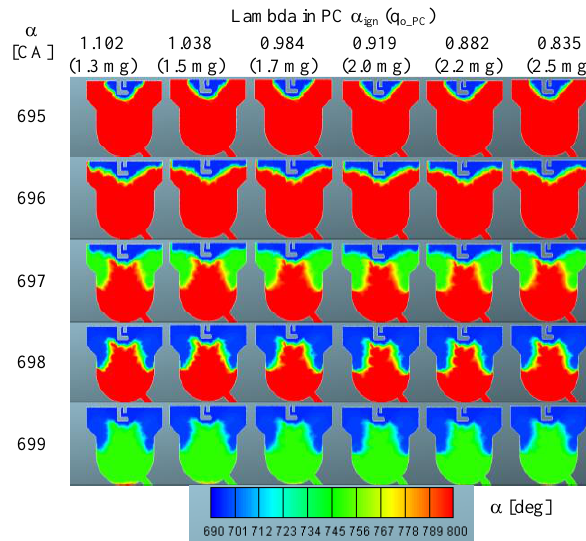
Fig. 10. Flame development (blue area) in the prechamber at different fuel dose values q o _PC